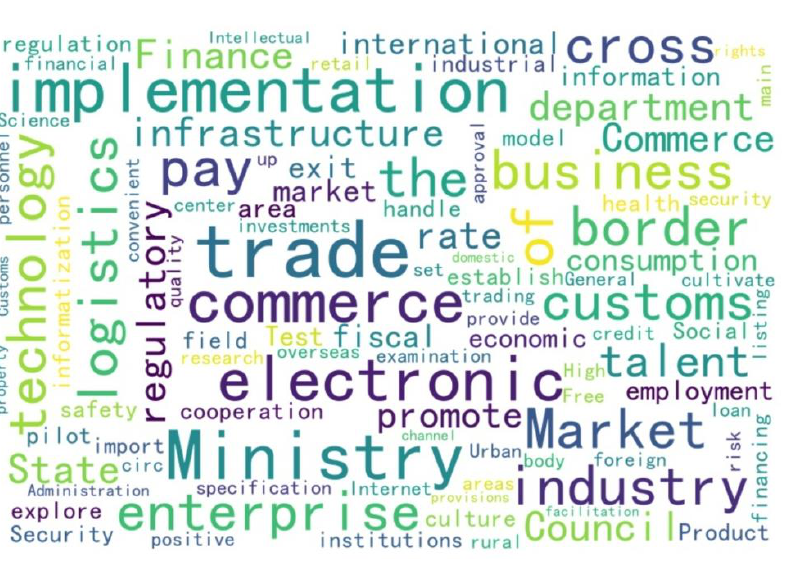
Figure 3. Word cloud diagram.